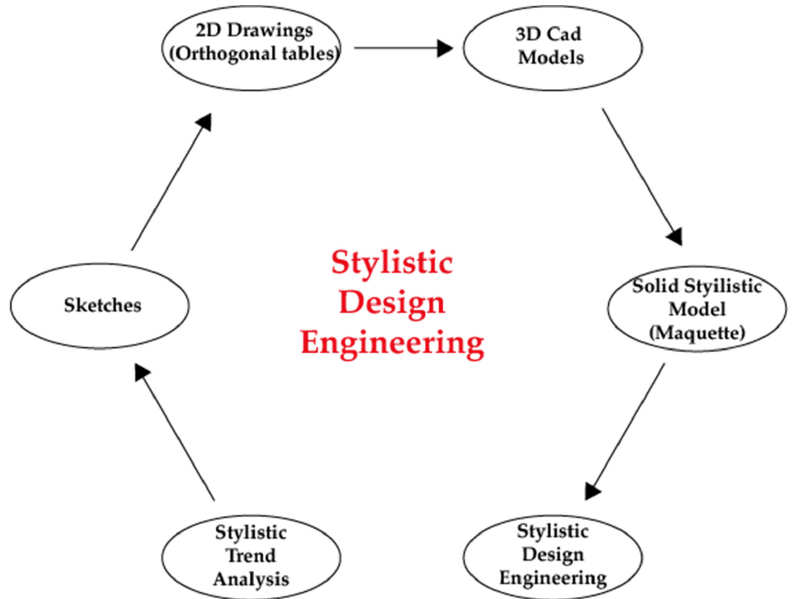
Figure 3. SDE method outline.